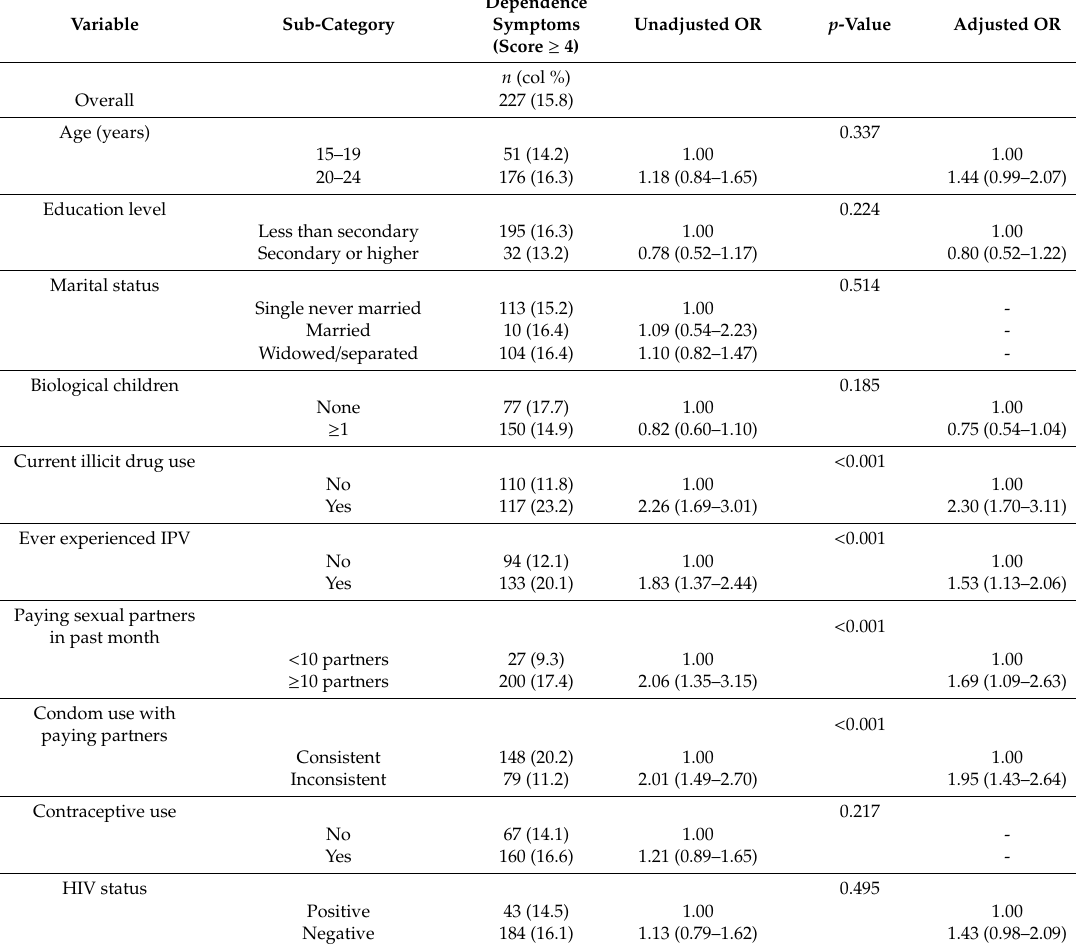
Table 5. Factors associated with dependence symptoms among